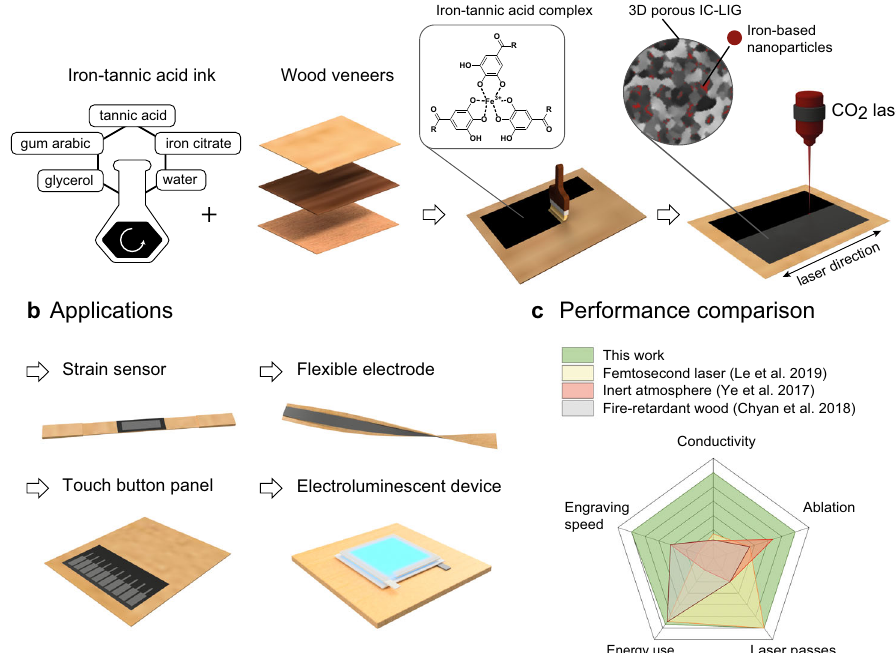
Fig. 1 Iron-catalyzed laser-induced graphitization (IC-LIG) of wood and applications thereof. a Schematic representation of the IC-LIG process. The substrate (e.g., a wood veneer) is coated with an iron-tannic acid ink (the inset shows a simpli fi ed structure of the iron-tannic acid complex contained in the ink, see also Supplementary Fig. 1). The ink-coated wood veneer is then treated with a CO 2 laser to achieve IC-LIG (the inset shows a schematic of the resulting 3D porous iron-carbon composite). b Proof-of-concept applications demonstrated in this work for IC-LIG structures on wood veneers: a strain sensor, a fl exible electrode, a touch buttons panel, and an electroluminescent device. c A radar plot comparing the performance of our IC-LIG with other previously published LIG approaches in terms of process parameters (faster engraving speed, lower energy use, only one laser pass needed) and quality (higher electrical conductivity, lower substrate ablation) of the resulting LIG materials (see also Supplementary Table